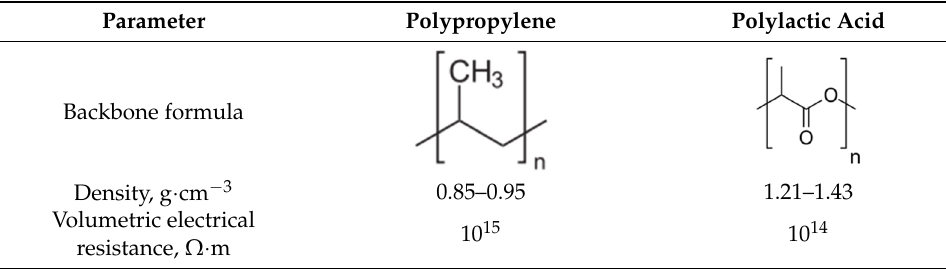
Table 1. Structure and some of the properties of fiber-forming polymers. Parameter